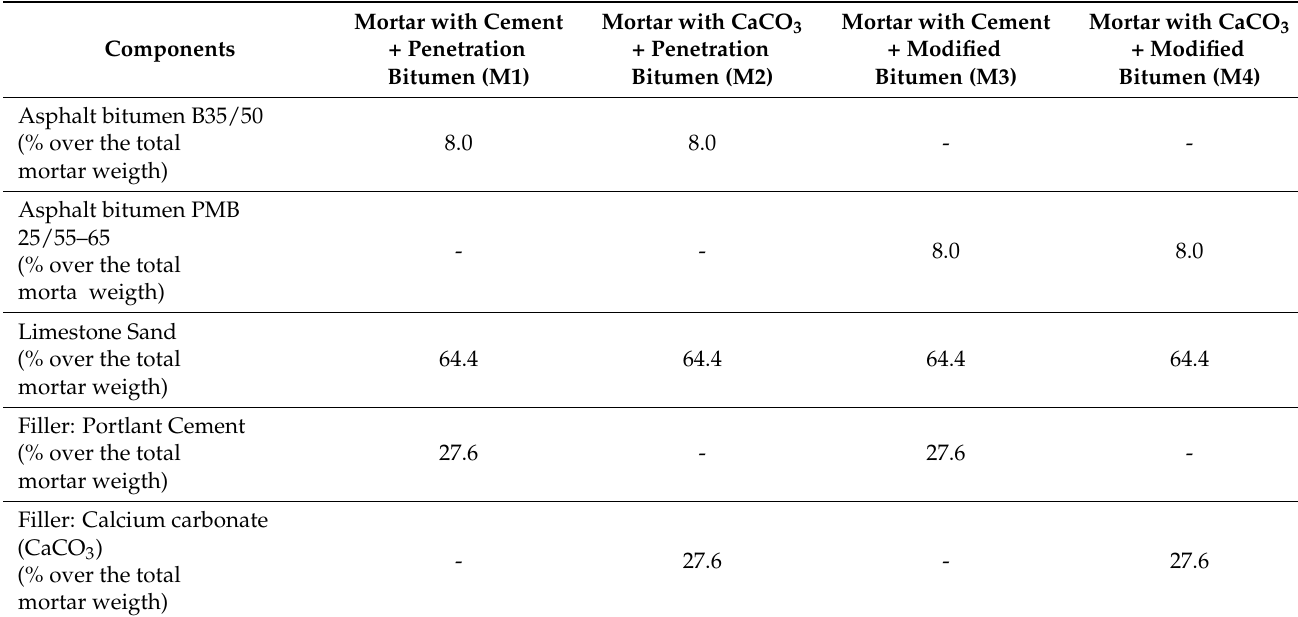
Table 1. Composition of the asphalt mortars studied.